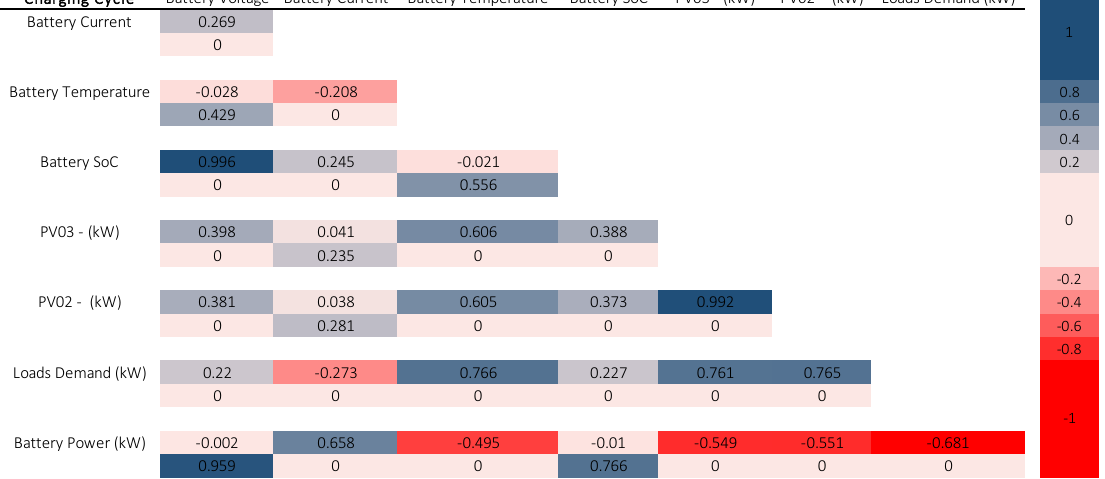
Figure 18. Diesel generator operation in off-grid condition.